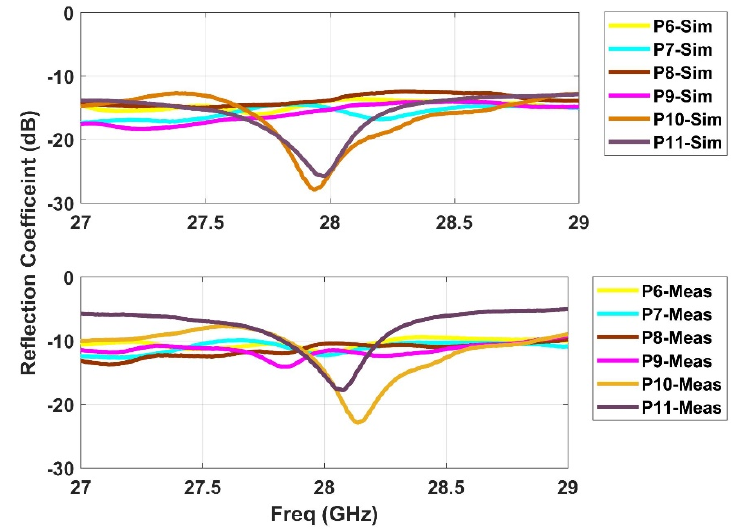
Figure 5. Simulated and measured s-parameters for the array ports (P6–P11).